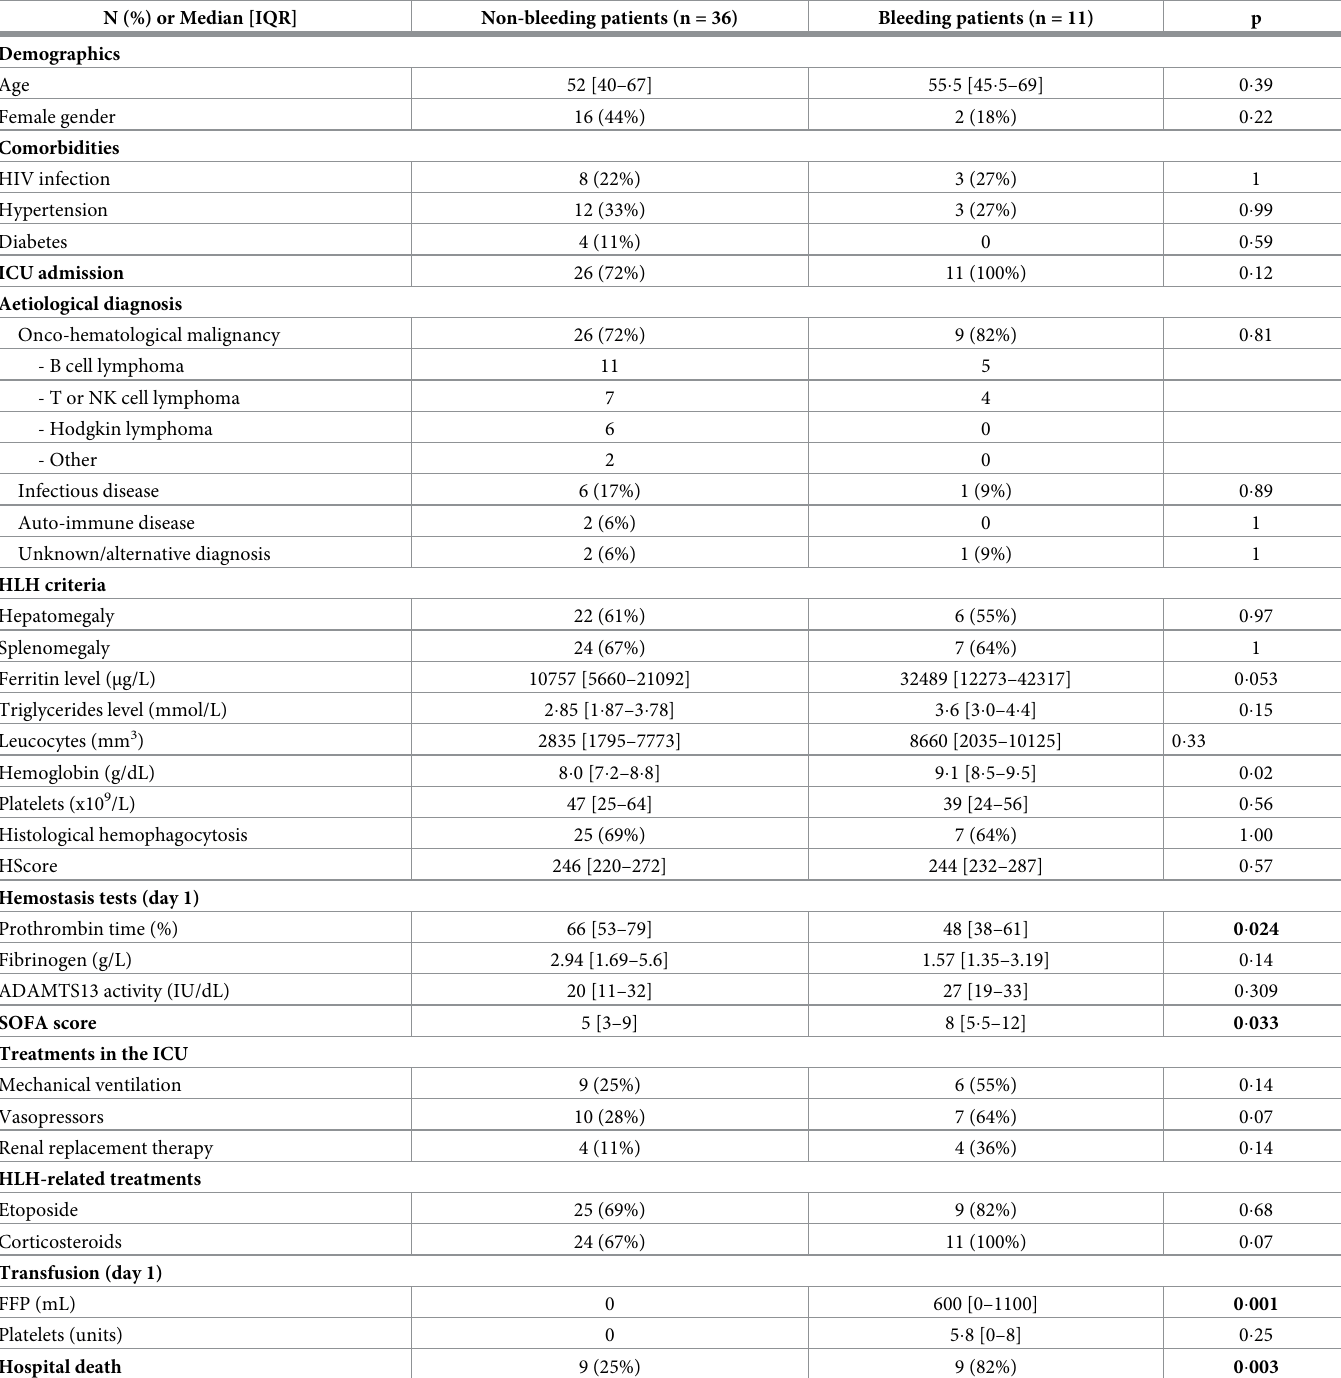
Table 2. Characteristics of patients with hemophagocytic lymphohistiocytosis according to the occurrence of a severe hemorrhage. N (%) or Median